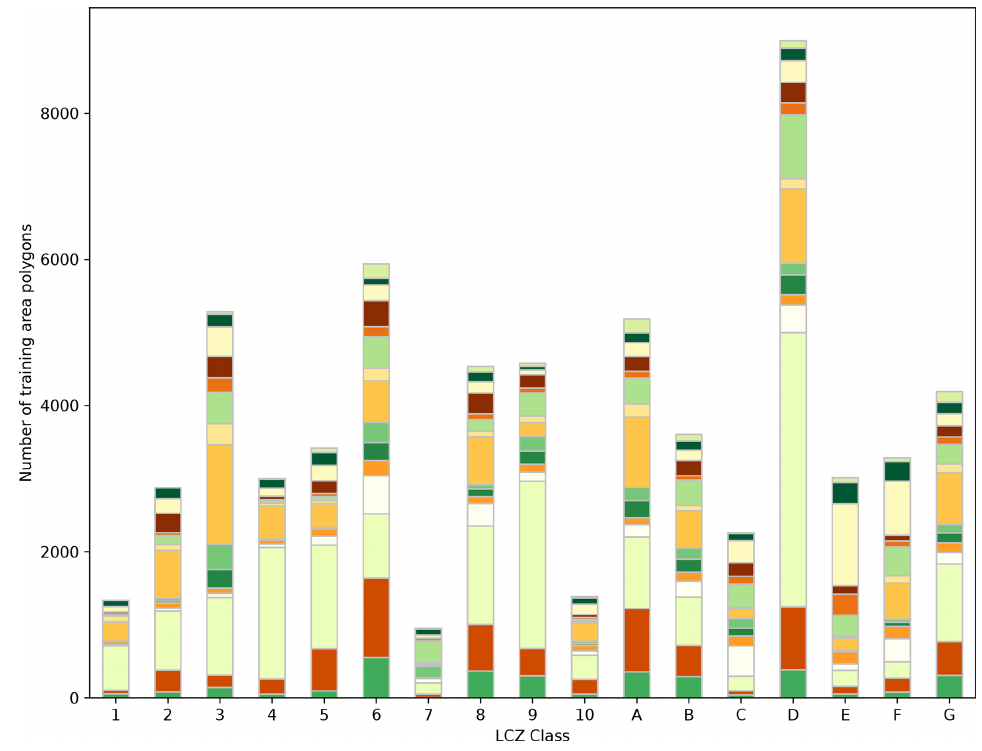
Figure E1. Number of training area polygons per LCZ class and ER (colours as in Fig. 3).